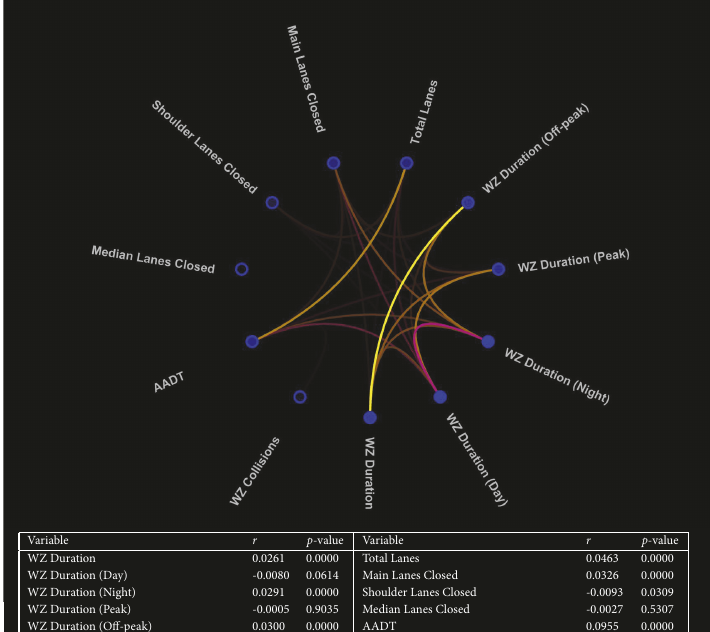
Figure 8: Numeric values indicate correlation between (continuous and ordinal) input variables and number of WZ collisions. Yellow and magenta denote positive and negative correlation, respectively. Brighter links indicate greater correlation, while less visible links imply low correlation. Unfilled tokens indicate that a variable has low total absolute correlation with other covariates